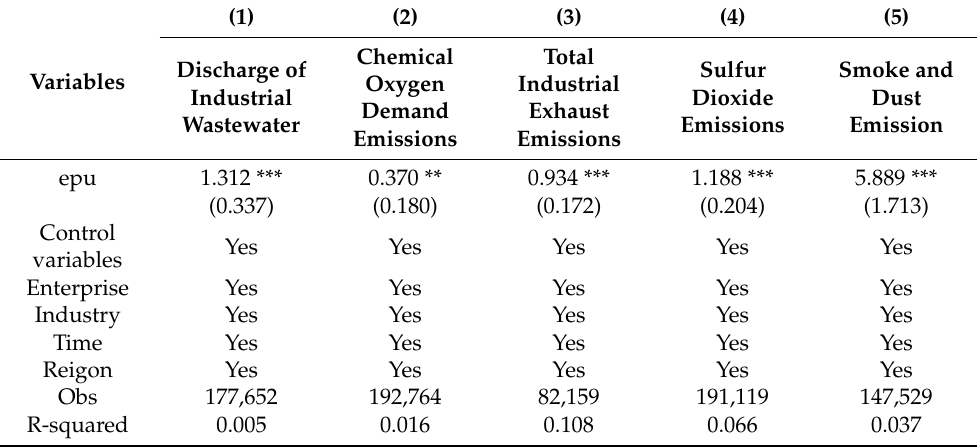
Table 8. Change the explained variable—pollution emission intensity of enterprises.